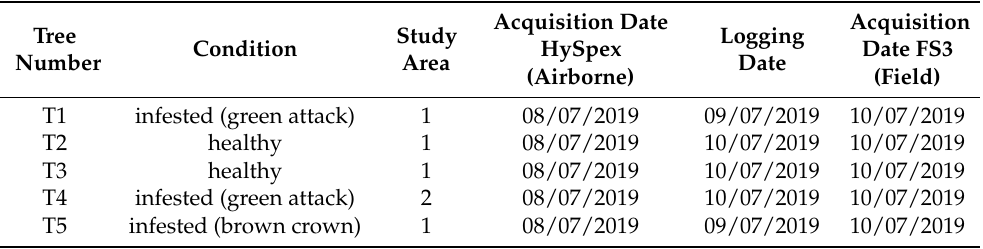
Table 1. State of the sampled trees (T = trees). Two spruces are healthy (T2, T3), two are infested in an early stage (green attack) (T1, T4) and one is infested in a late stage (brown crown) (T5). Study Tree Condition Number